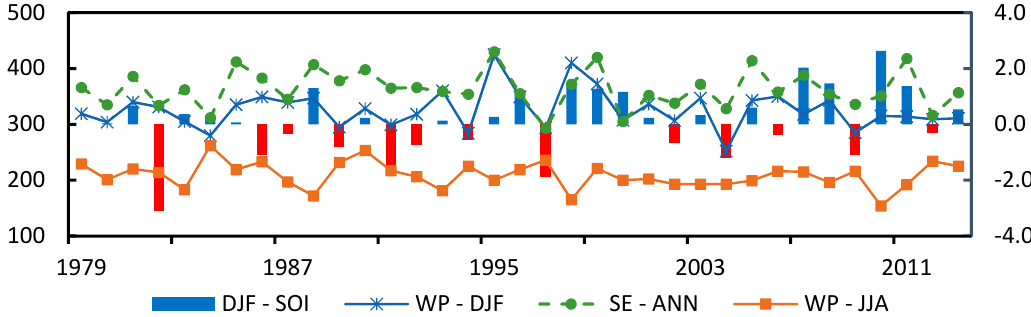
Figure 9. Wind power in winter (WP-DJF) and summer (WP-JJA), South East region annual wind power (SE-ANN) and winter SOI (DJF-SOI) for the study period considered.